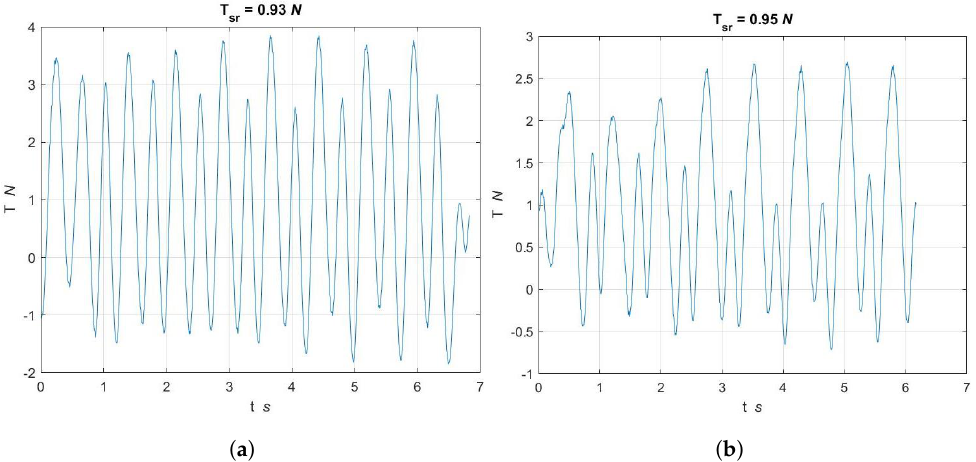
Figure 10. The thrust value as a function of time for fins dimensions: width 55 mm, thickness 1 mm and length: ( a ) 150 mm; ( b ) 330 mm.